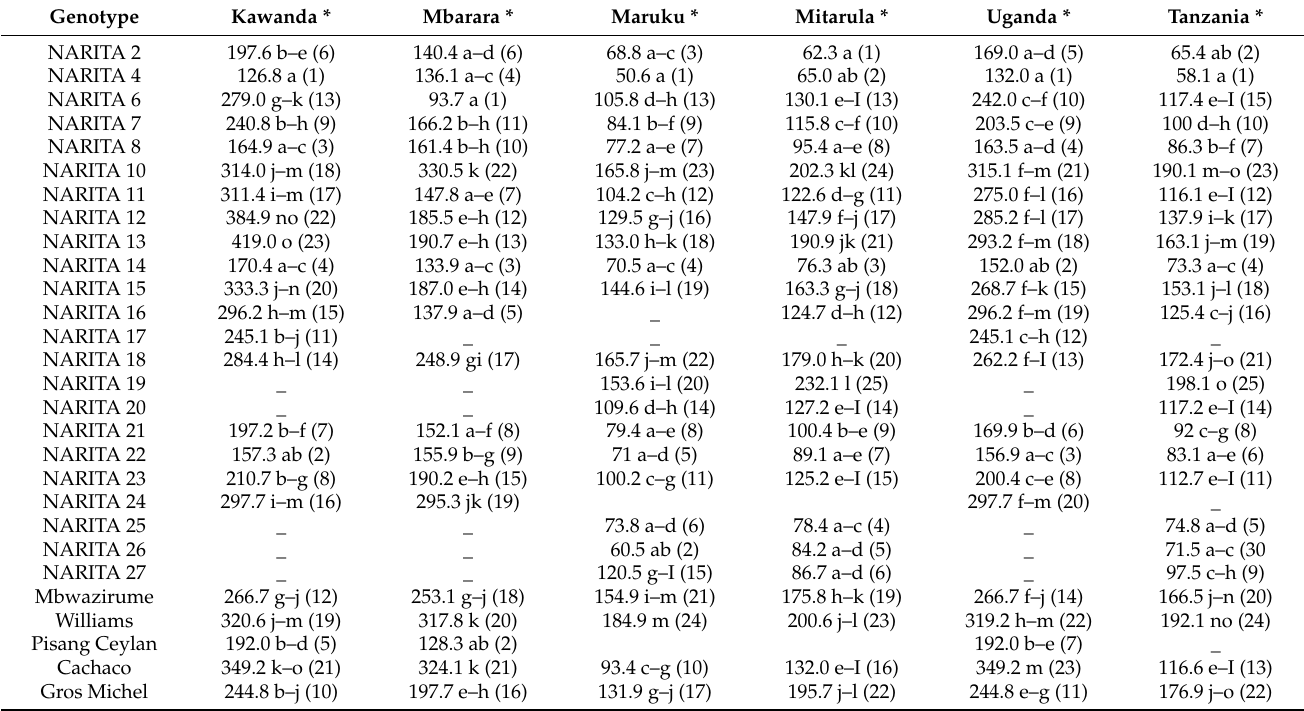
Table 4. Disease severity (AUDPC) of black Sigatoka on Matooke hybrids (NARITAs) and banana varieties evaluated at four different locations in Uganda and Tanzania during cycle